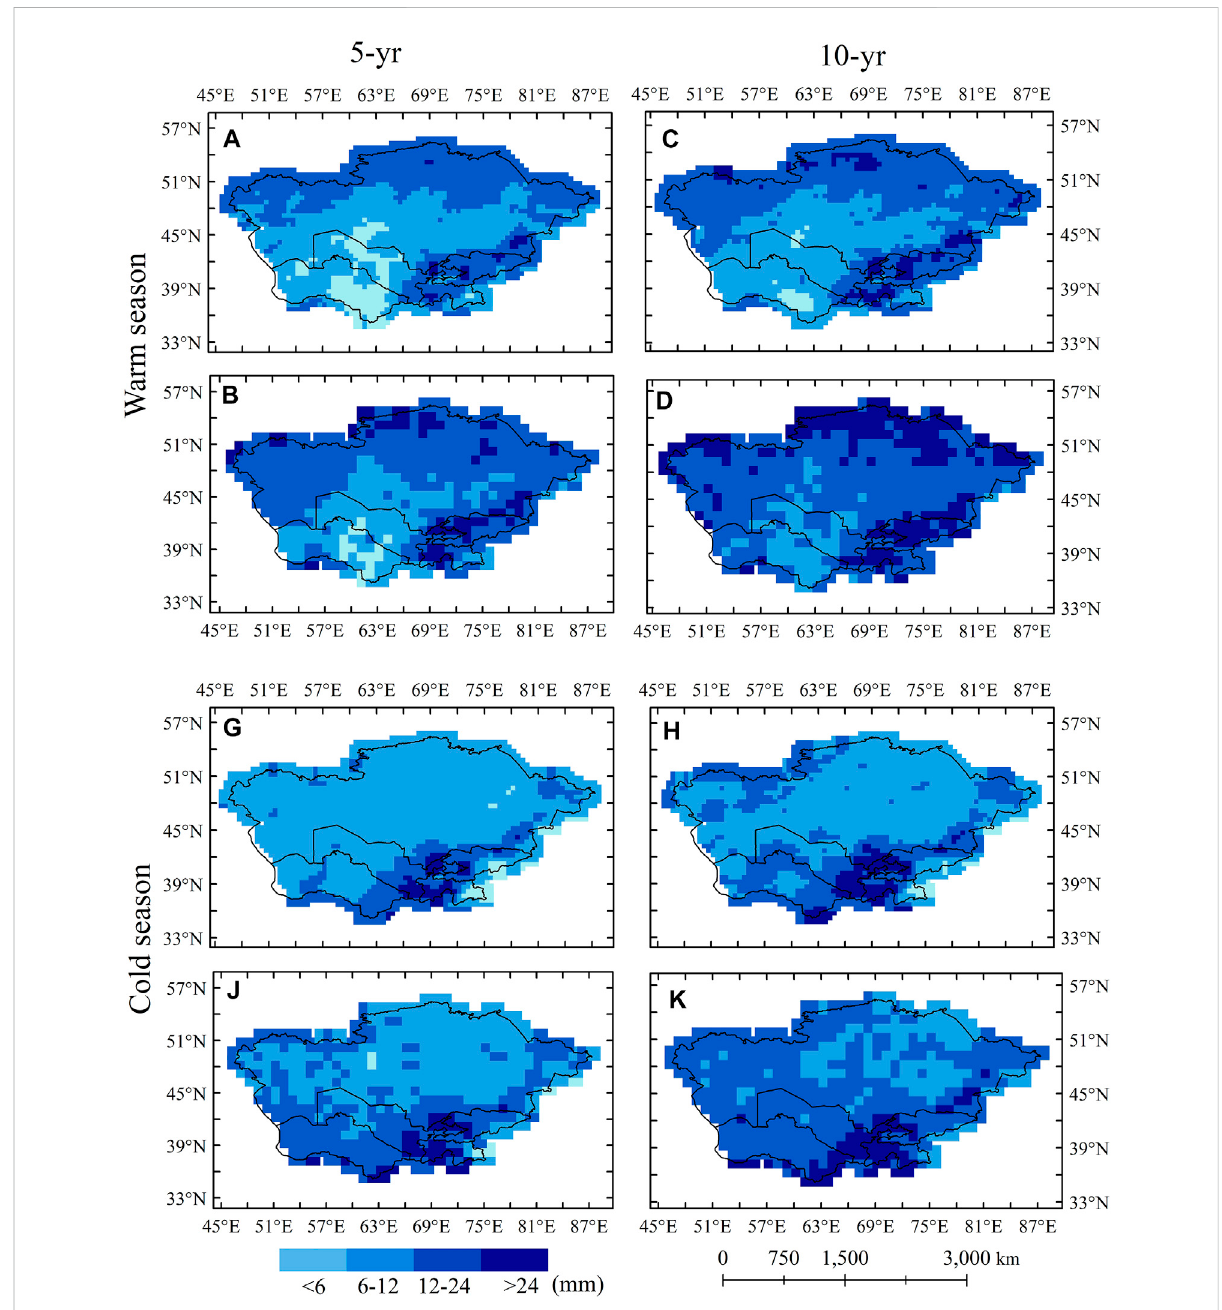
FIGURE 8 The threshold spatial distribution of APHRODITE (A,C,G,H) and GPCC (B,D,J,K) datasets by the parametric apporach in warm and cold season over Central